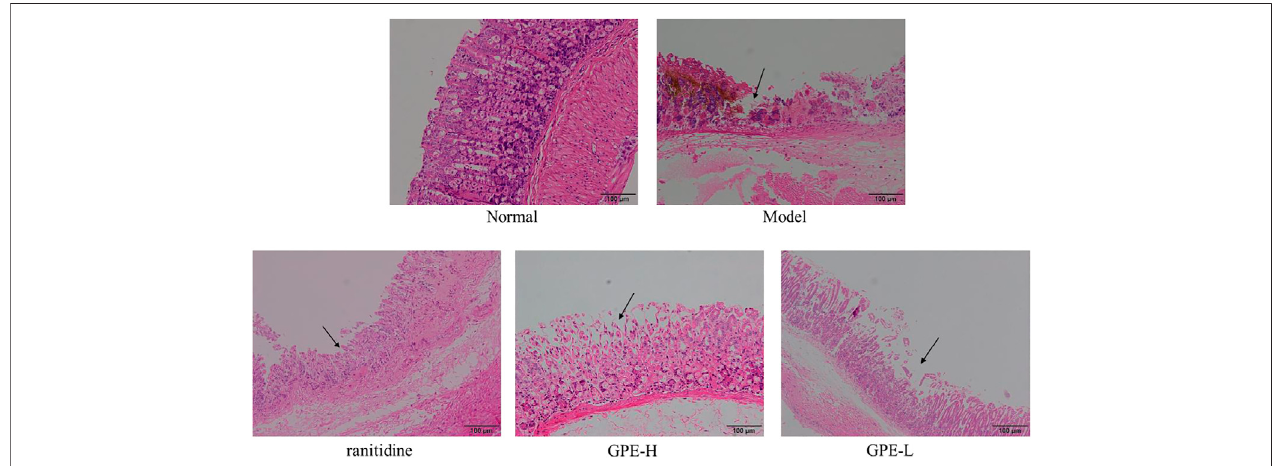
FIGURE 4 | Histopathological observation of gastric tissues sections in mice of the different groups after staining with hematoxylin and eosin (H&E).